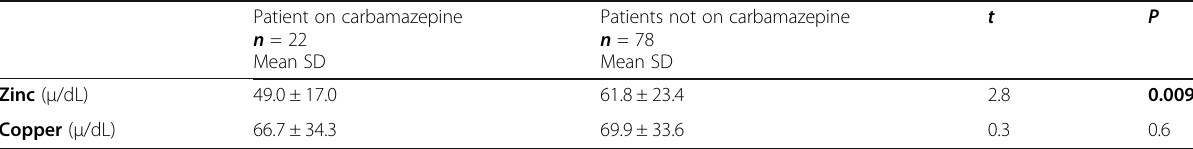
Table 6 Comparison between patients with and without carbamazepine intake as regards mean zinc and copper serum level